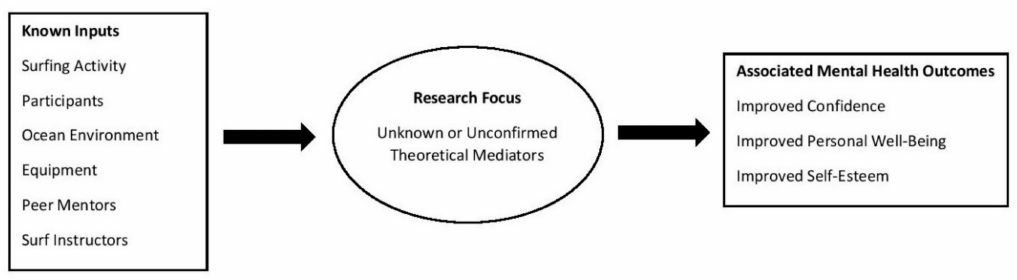
Figure 1. Preliminary logic